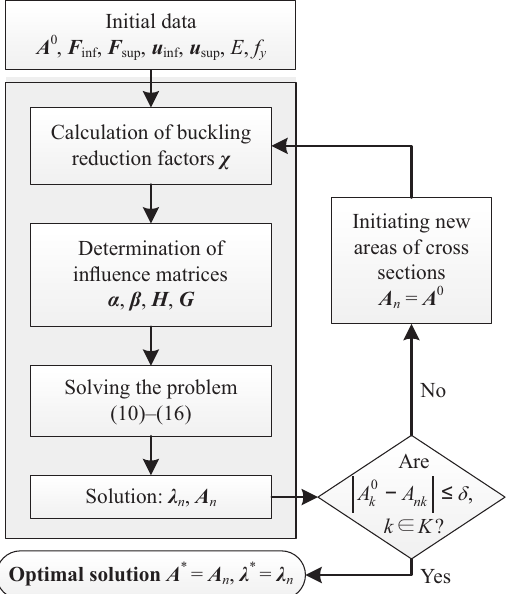
Fig. 2. Flowchart of the proposed solution algorithm